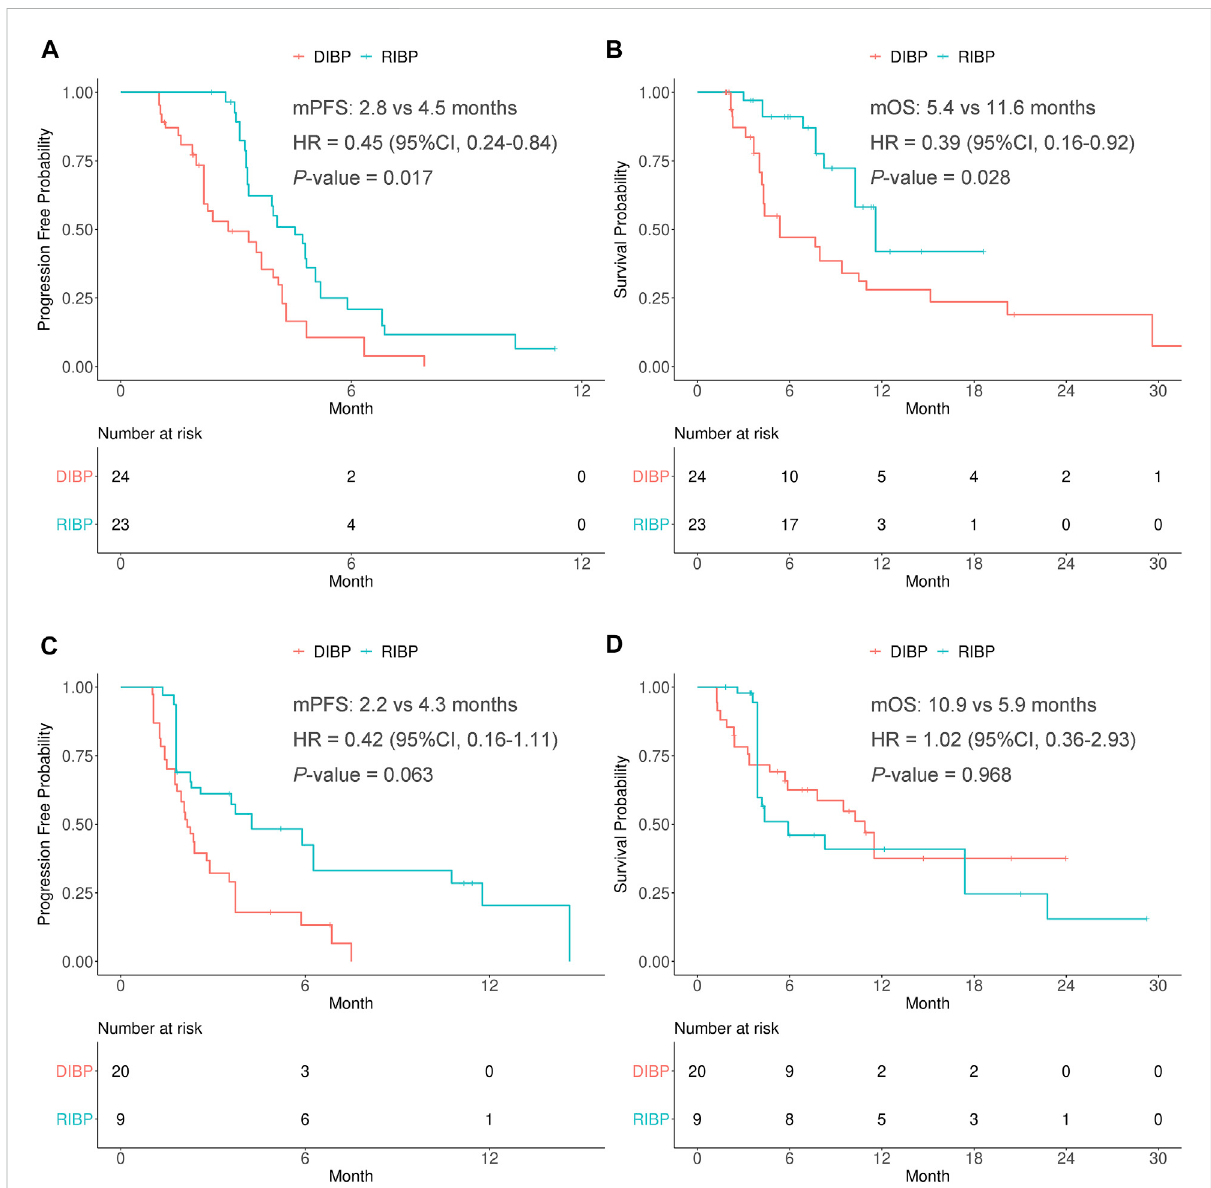
FIGURE 2 Kaplan-Meier curves of PFS (A,C) and OS (B,D) from weighted data in fi rst-line and second-line or later subgroups. RIBP, rechallenge of immunotherapy beyond progression; DIBP, discontinuation of immunotherapy beyond progression; mPFS, median progression-free survival; mOS, median overall survival; HR, hazard ratio; CI, con fi dence